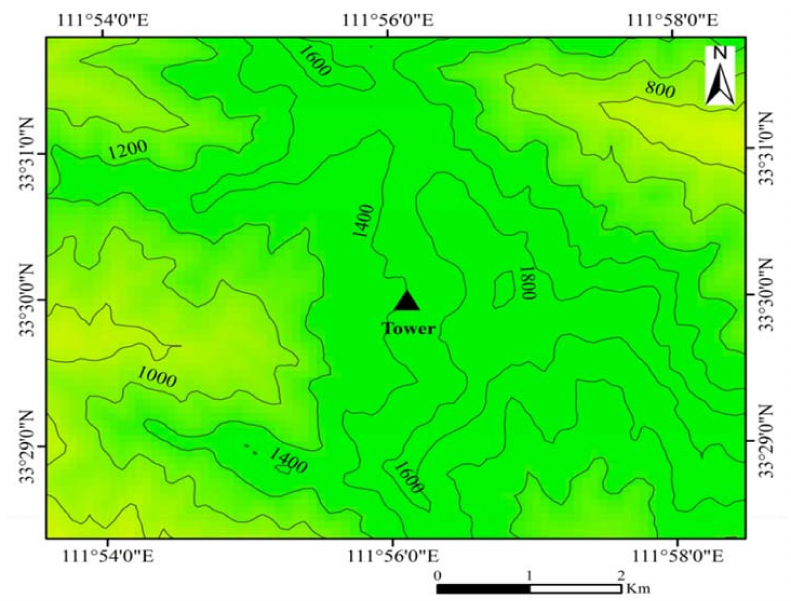
Figure 2. The topographical map of flux observation site at Baotianman forest ecosystem research